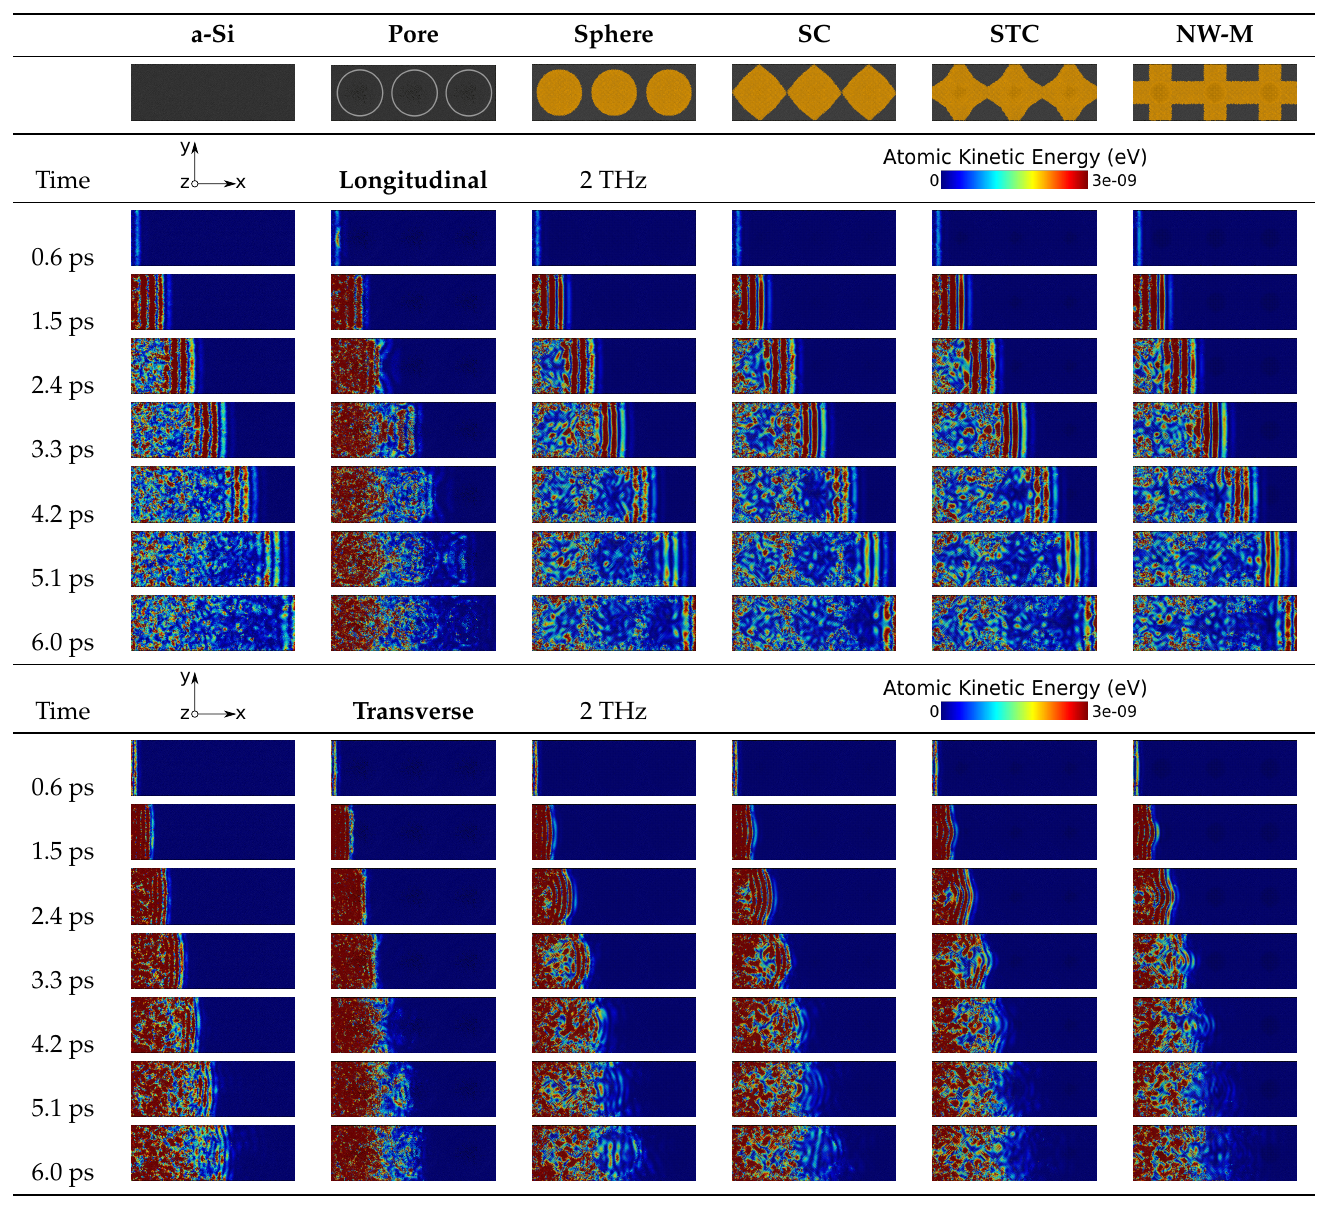
Table 2. Cross-sectional view of a WP going through the different systems after a longitudinal excitation at 2 THz (first part of the table) or a transverse excitation at the same frequency (second part of the table) every 0.9 ps. The first line represents the geometry of the cross-sections at the middle of simulation box with inclusions in yellow and matrix in dark grey.